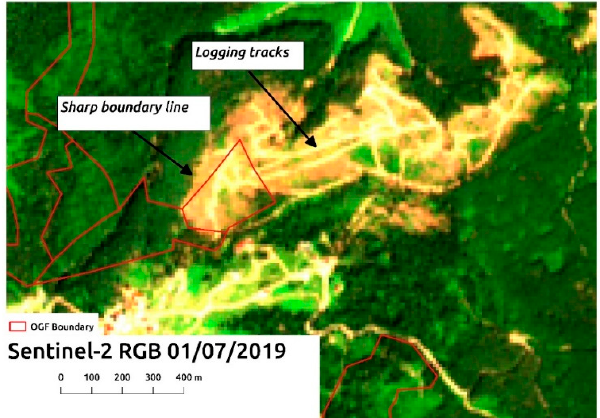
Figure 4. Summer 2019 (1st July) Sentinel-2 RGB image of an area of disturbed Norway spruce- dominated OGF. The disturbance was classified as manmade due to sharply-defined disturbance boundaries and logging tracks. Red lines show boundaries of OGF shapefiles.